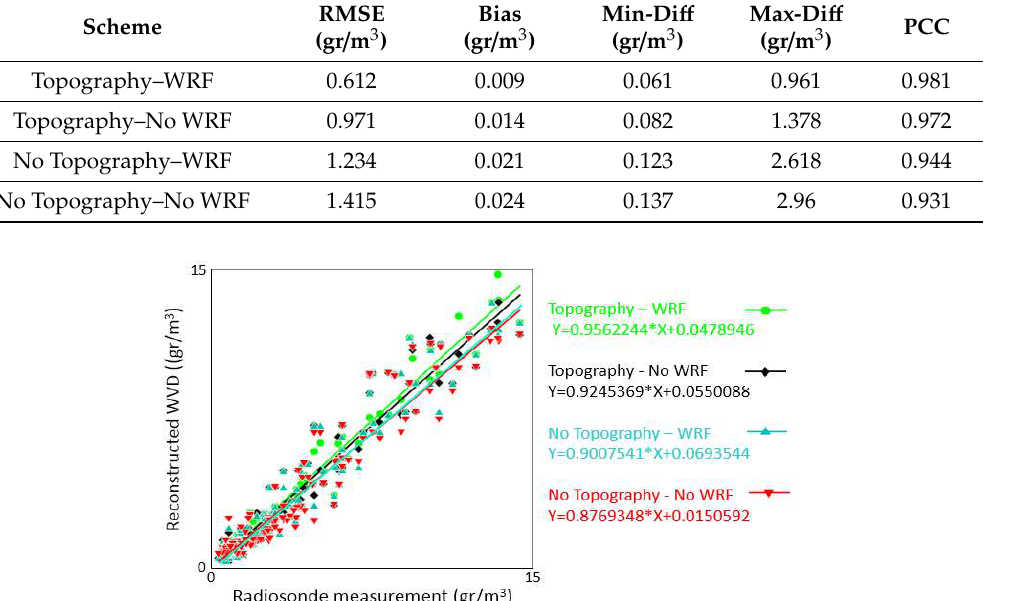
Figure 14. Positioning RMSE in different weather conditions. Table 3. Comparison of the obtained RMSE.